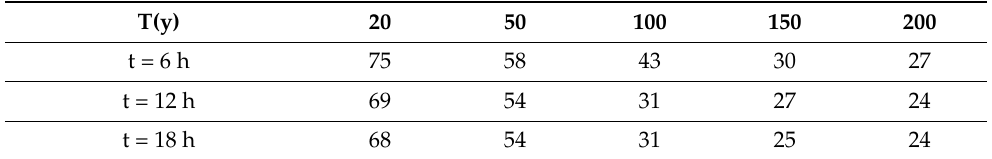
Table 7. Reduction in the average hazard (%) on Koropouli Street due to the presence of the flood protection